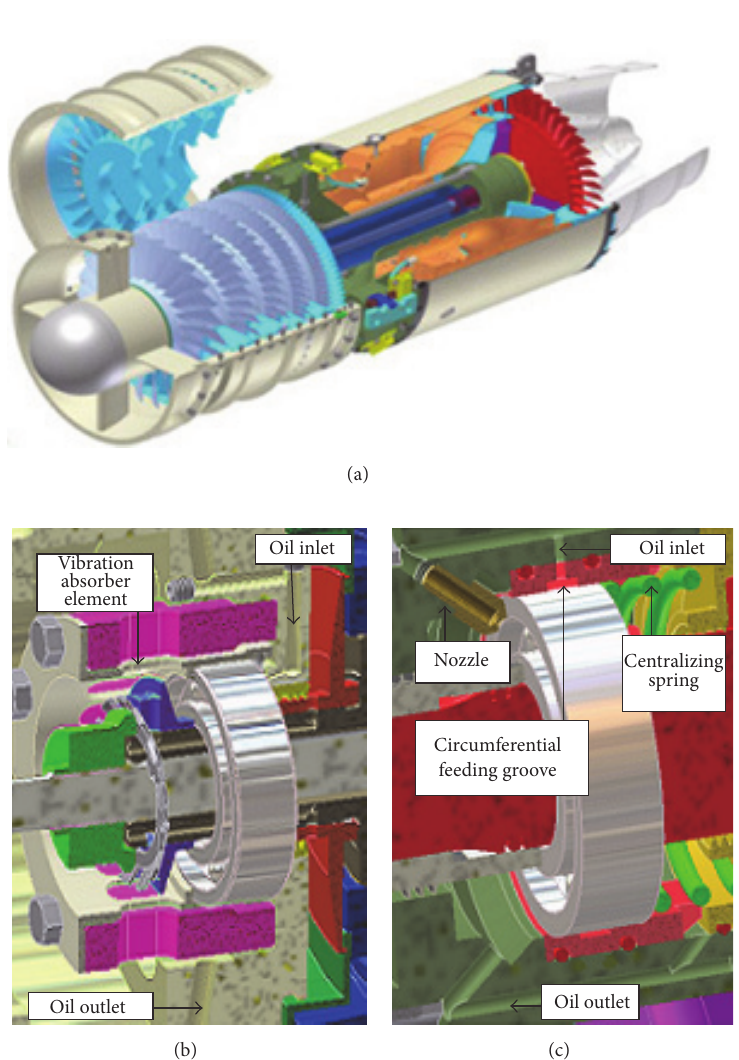
Figure 2: Three-dimensional illustration of the cross-section of the developed gas turbine: (a) bipartite mounting of the axial compressor and other inner components; (b) front or cold bearing; and (c) rear or hot